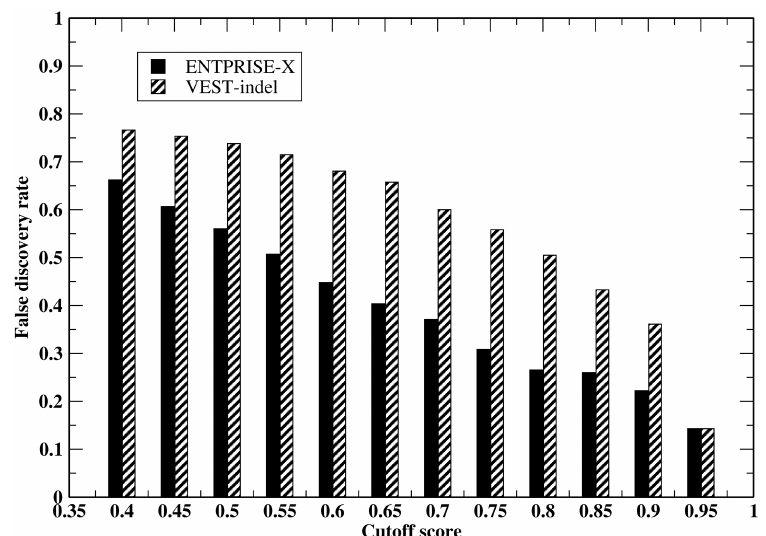
Fig 2. False discovery rate by the ENTPRISE-X and VEST-indel methods at various cutoffs on the VEST-indel test set.